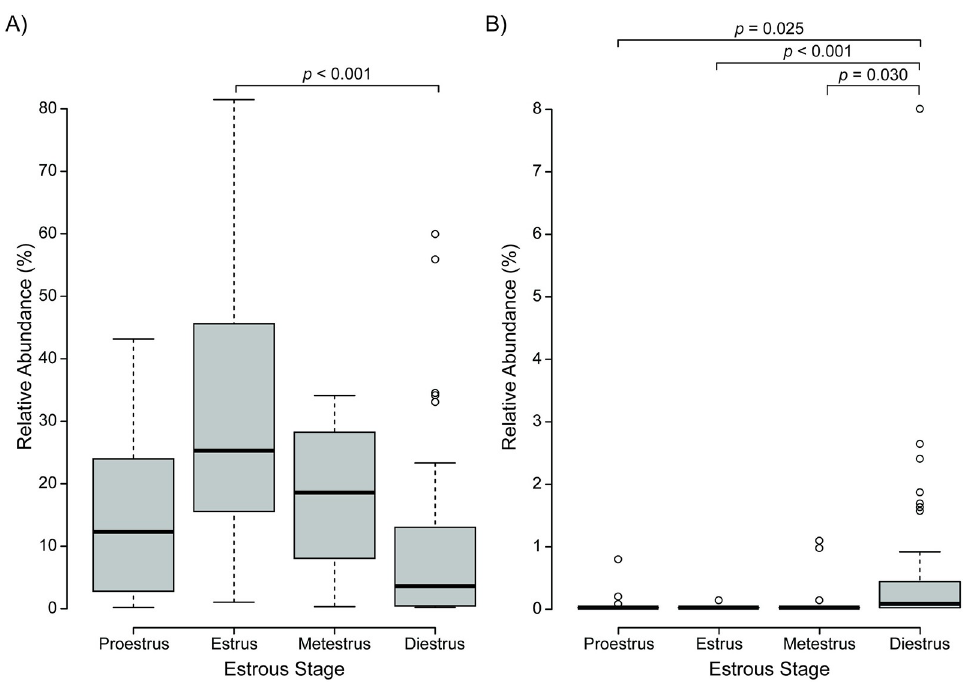
Fig 3. Variations in OTU abundances based on estrous phase characterization. A) OTU3 ( Streptococcus ) for Control and Treatment animals during baseline period. B) OTU7 ( Corynebacterium ) for Control and Treatment animals during baseline period. Similar trends were observed for both OTU3 and OTU7 when separated into Control-only and Treatment-only analyses.